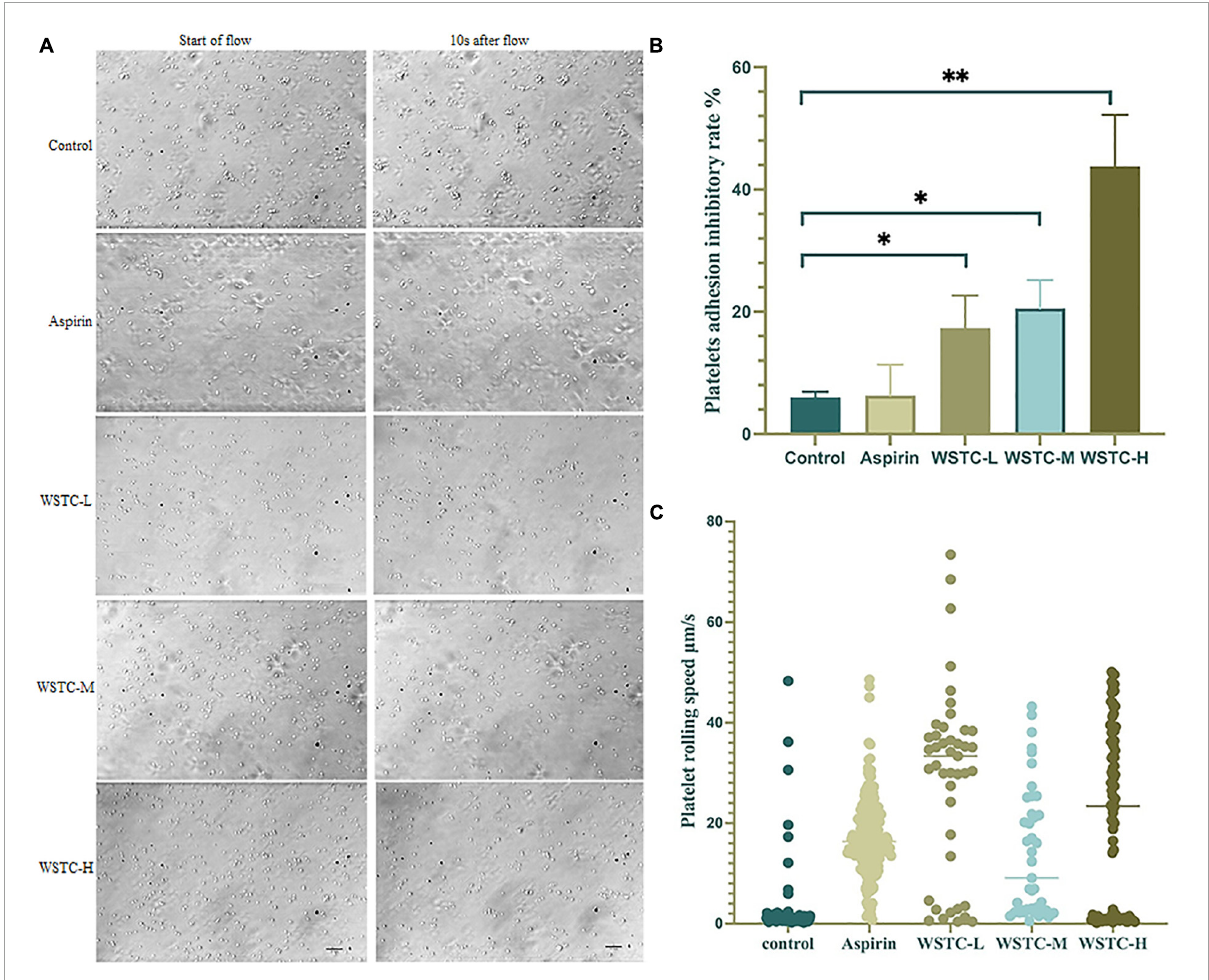
FIGURE2 Effects of water-soluble tomato concentrate (WSTC) on Von Willebrand Factor (vWF)-mediated platelet adhesion and rolling velocity under shear stress. (A) Representative images showing effects of vWF-mediated platelet adhesion under 6 Pa shear stress in each group, the first image of each row was taken at the beginning of the flow, and the second image shown is at 10 s after flow. The scale bar is 20 µ m. (B) Mean platelet adhesion inhibitory rate of the control group, WSTC-L, WSTC-M, WSTC-H, and Aspirin group under the conditions shown in (A) , the inhibitory rate was calculated as follows: (adhesion platelet numbers at beginning − adhesion platelet numbers after 10 s shear flow)/adhesion platelet numbers at beginning × 100%. ∗ P < 0.05, compared to control group; ∗∗ P < 0.01, compared to control group. (C) Mean platelet rolling speed in the control group, WSTC-L, WSTC-M, WSTC-H groups, and Aspirin group under conditions shown in (A)